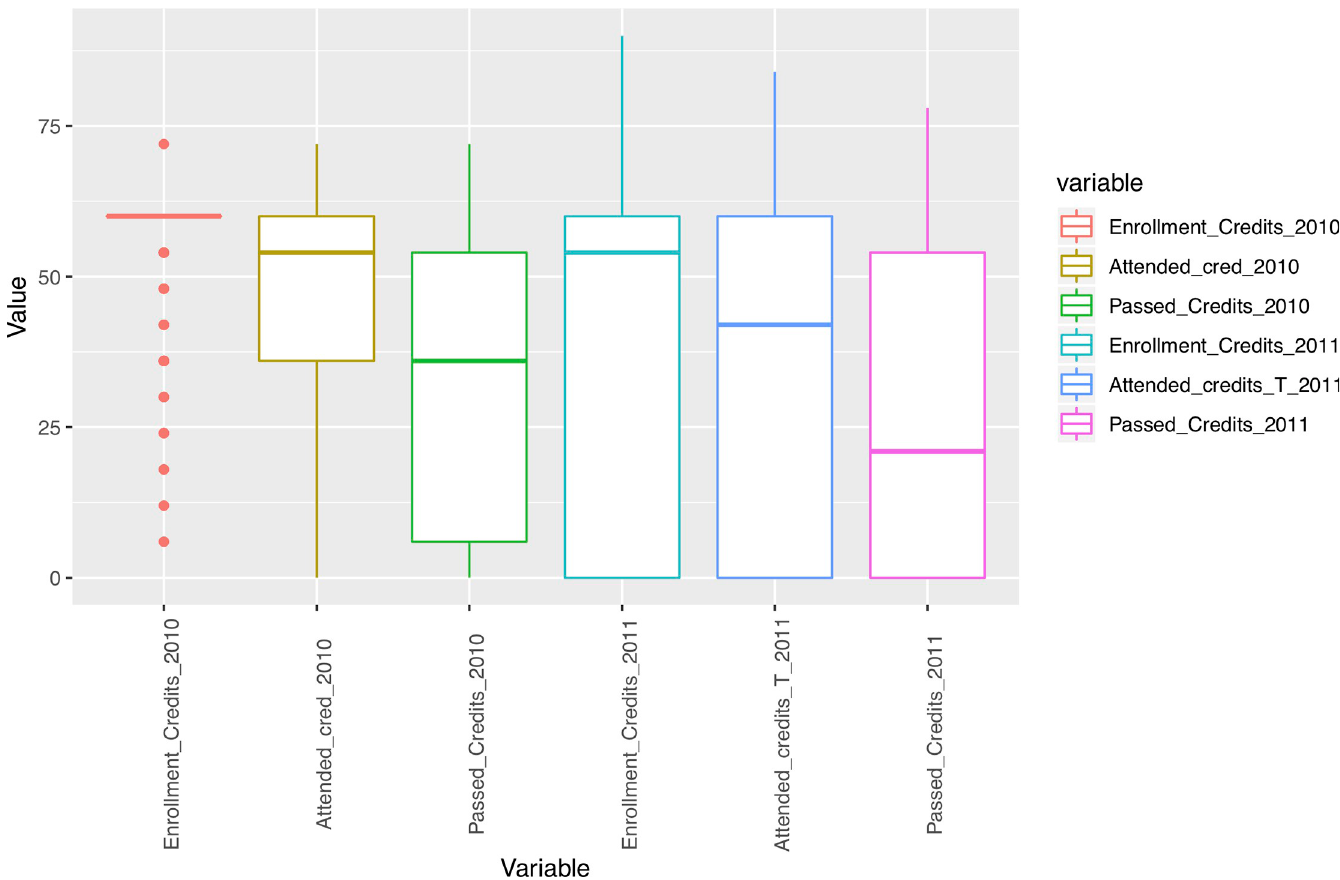
Fig 1. Box-plots for variables concerning number of